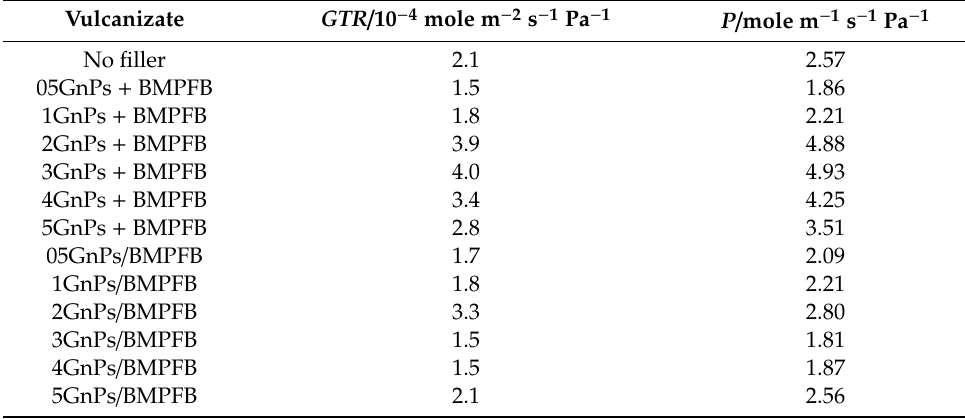
Table 7. Gas barrier properties of SBR